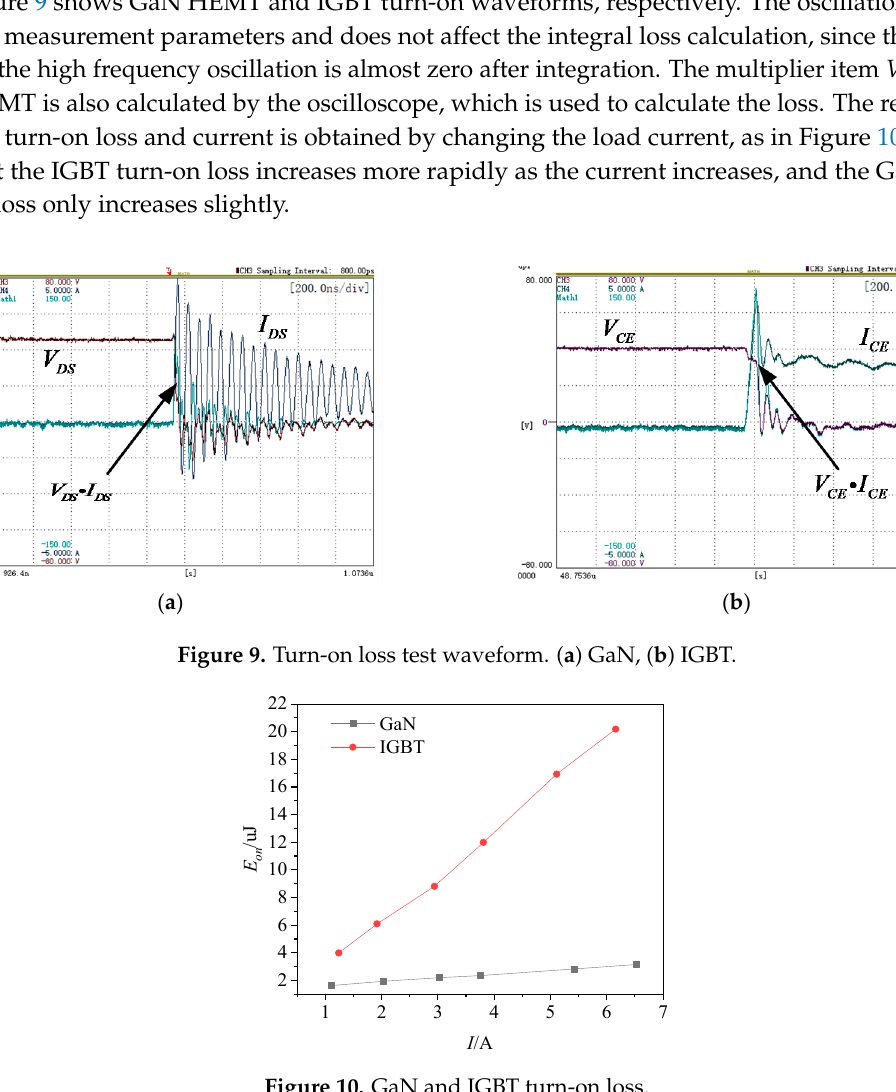
Figure 10. GaN and IGBT turn-on loss.